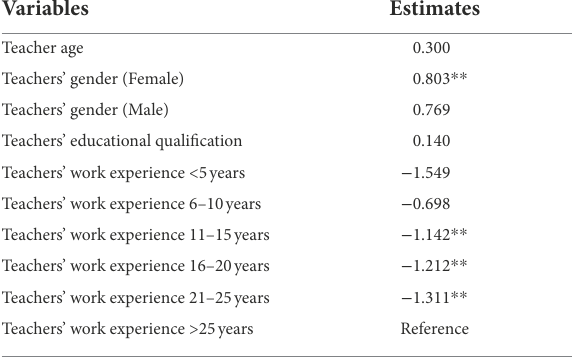
TABLE 3 Estimates of determinants of teachers’ career satisfaction. TABLE 4 Estimates of determinants of teachers’ attitude toward their